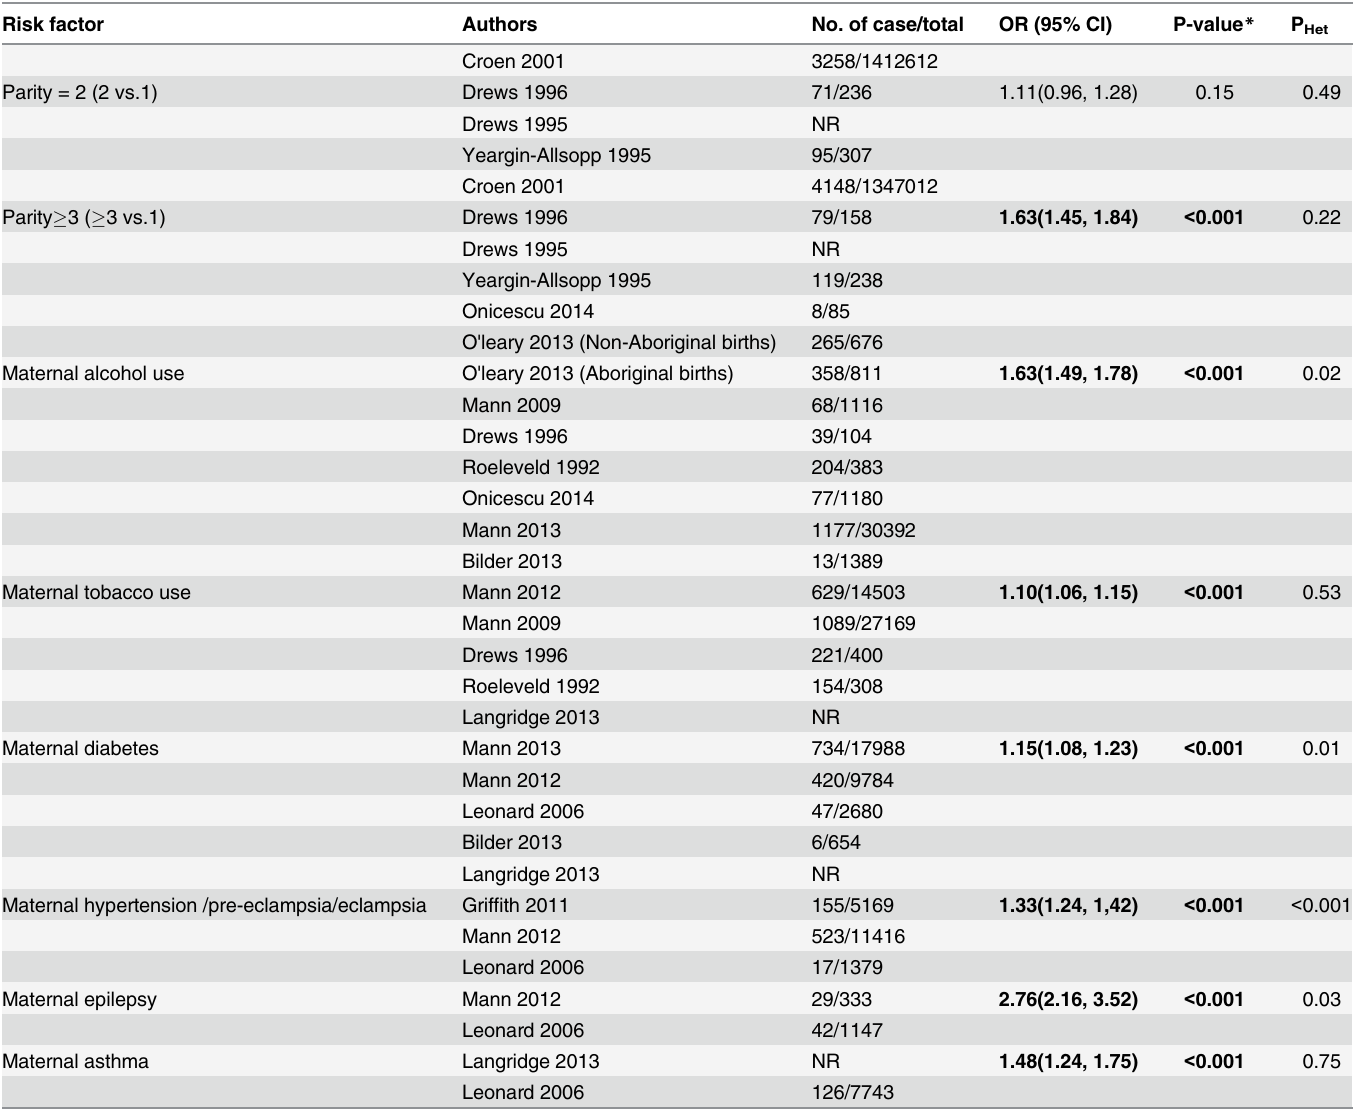
Table 3. Meta-analysis of prenatal risk factors for ID